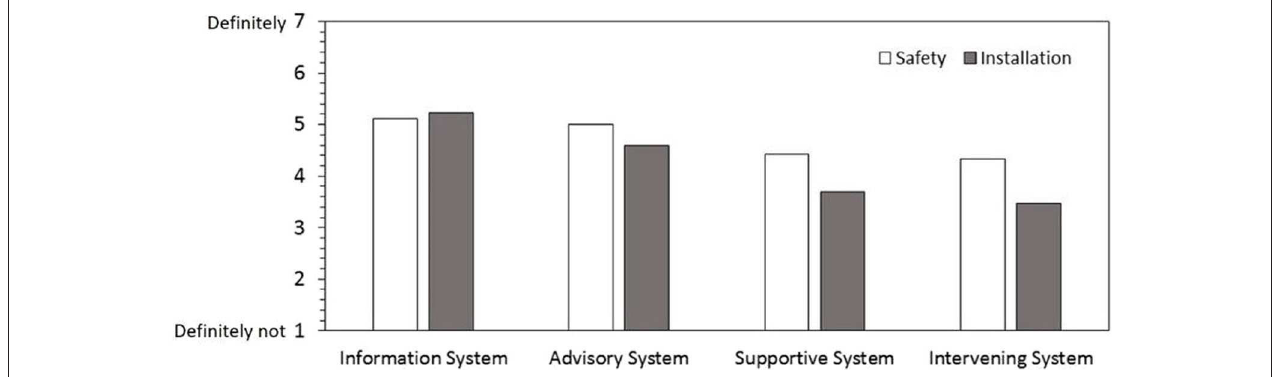
FIGURE 3 | Ratings of the safety benefits and likelihood of installation (from 1 = definitely not, to 7 = definitely) of four speed information systems.